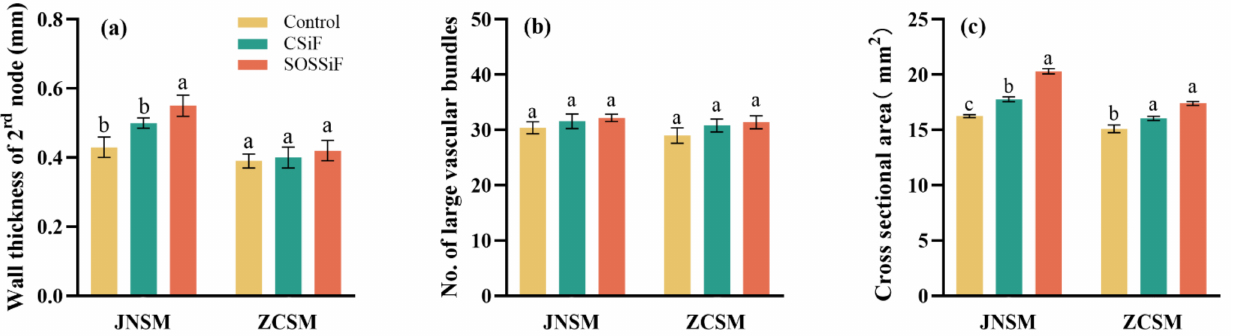
Figure 6. Effects of different Si treatments on anatomical traits of rice culms. ( a ) wall thickness, ( b ) number of large vascular bundles, ( c ) cross sectional area. Different small letters above the histogram of the same rice variety indicated significant